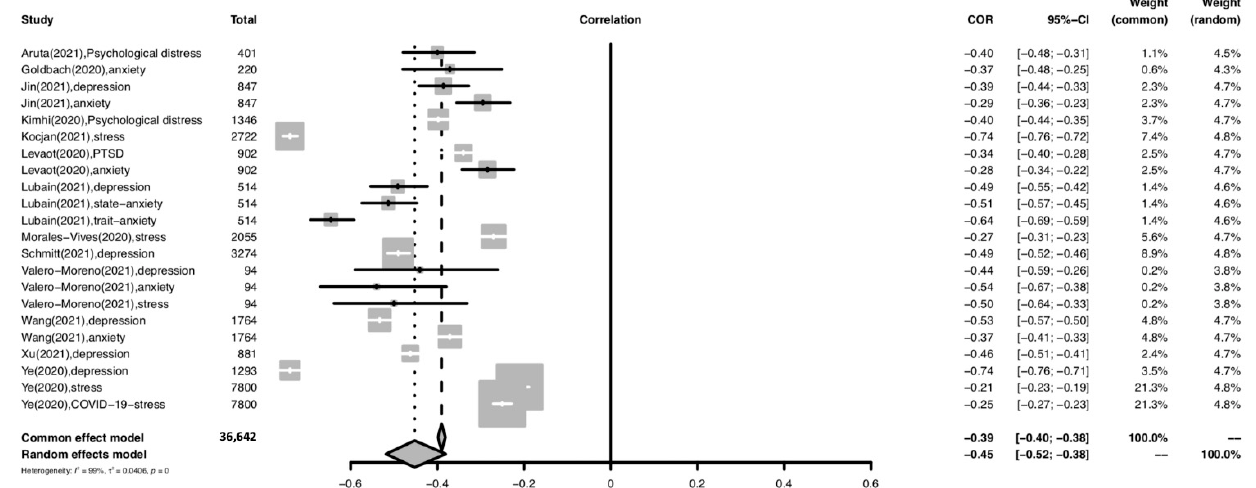
Figure 3. Forest plot of the relationship between resilience and psychological distress among the general population. Abbreviation: COR, correlation coefficient; CI, confidence interval; I 2 , indicator of statistical heterogeneity; p , p -value; τ 2 , indicator of statistical heterogeneity. Horizontal lines indicate the 95% CI of each study; diamonds indicate the pooled estimate with a 95% CI.